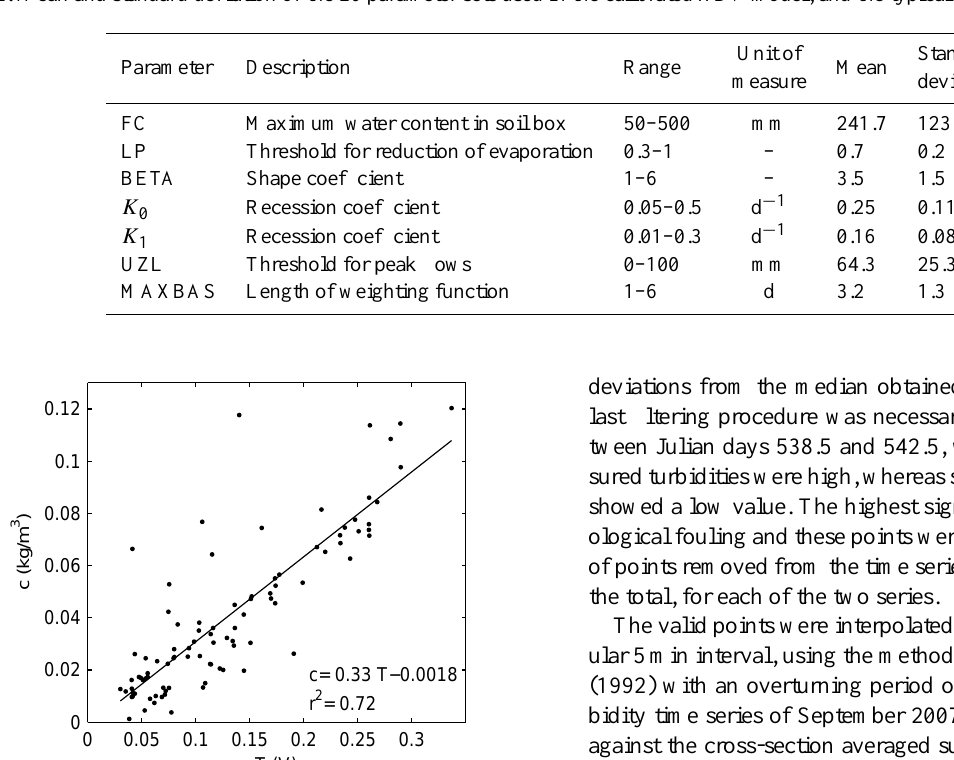
Table 2. Mean and standard deviation of the 20 parameter sets used in the calibrated HBV model, and the typical range of the parameters.